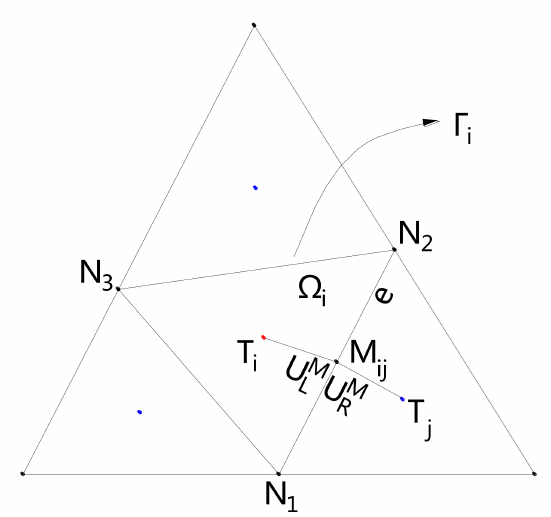
Figure 2. Notations of a typical triangular cell and its three